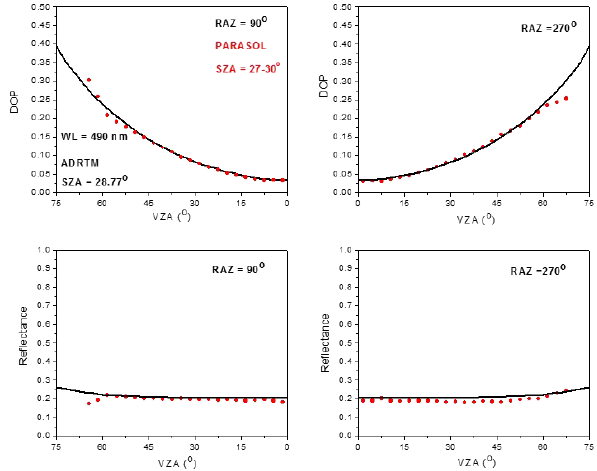
Figure 3. Same as in Fig. 2 but at RAZs of 90 and 270 ◦